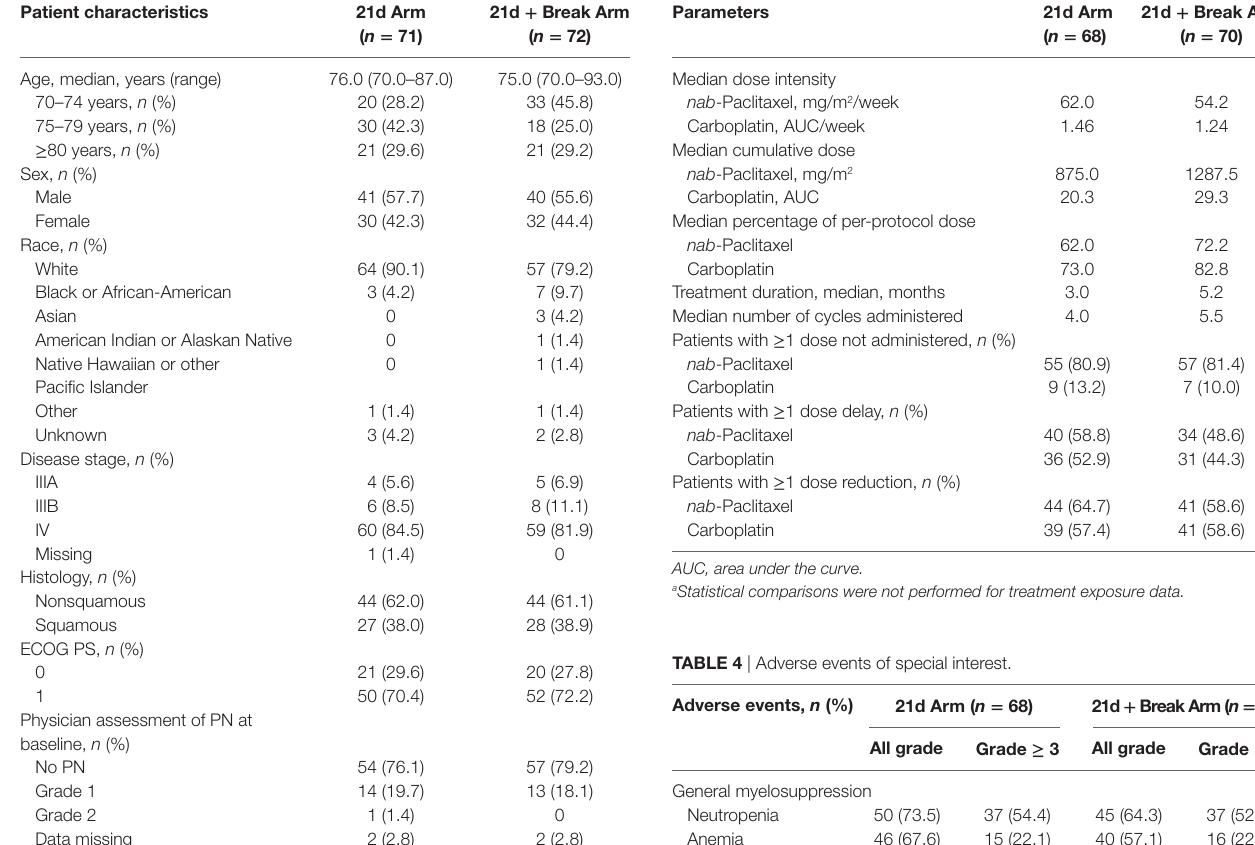
TaBle 3 | Treatment exposure a and dose modifications.